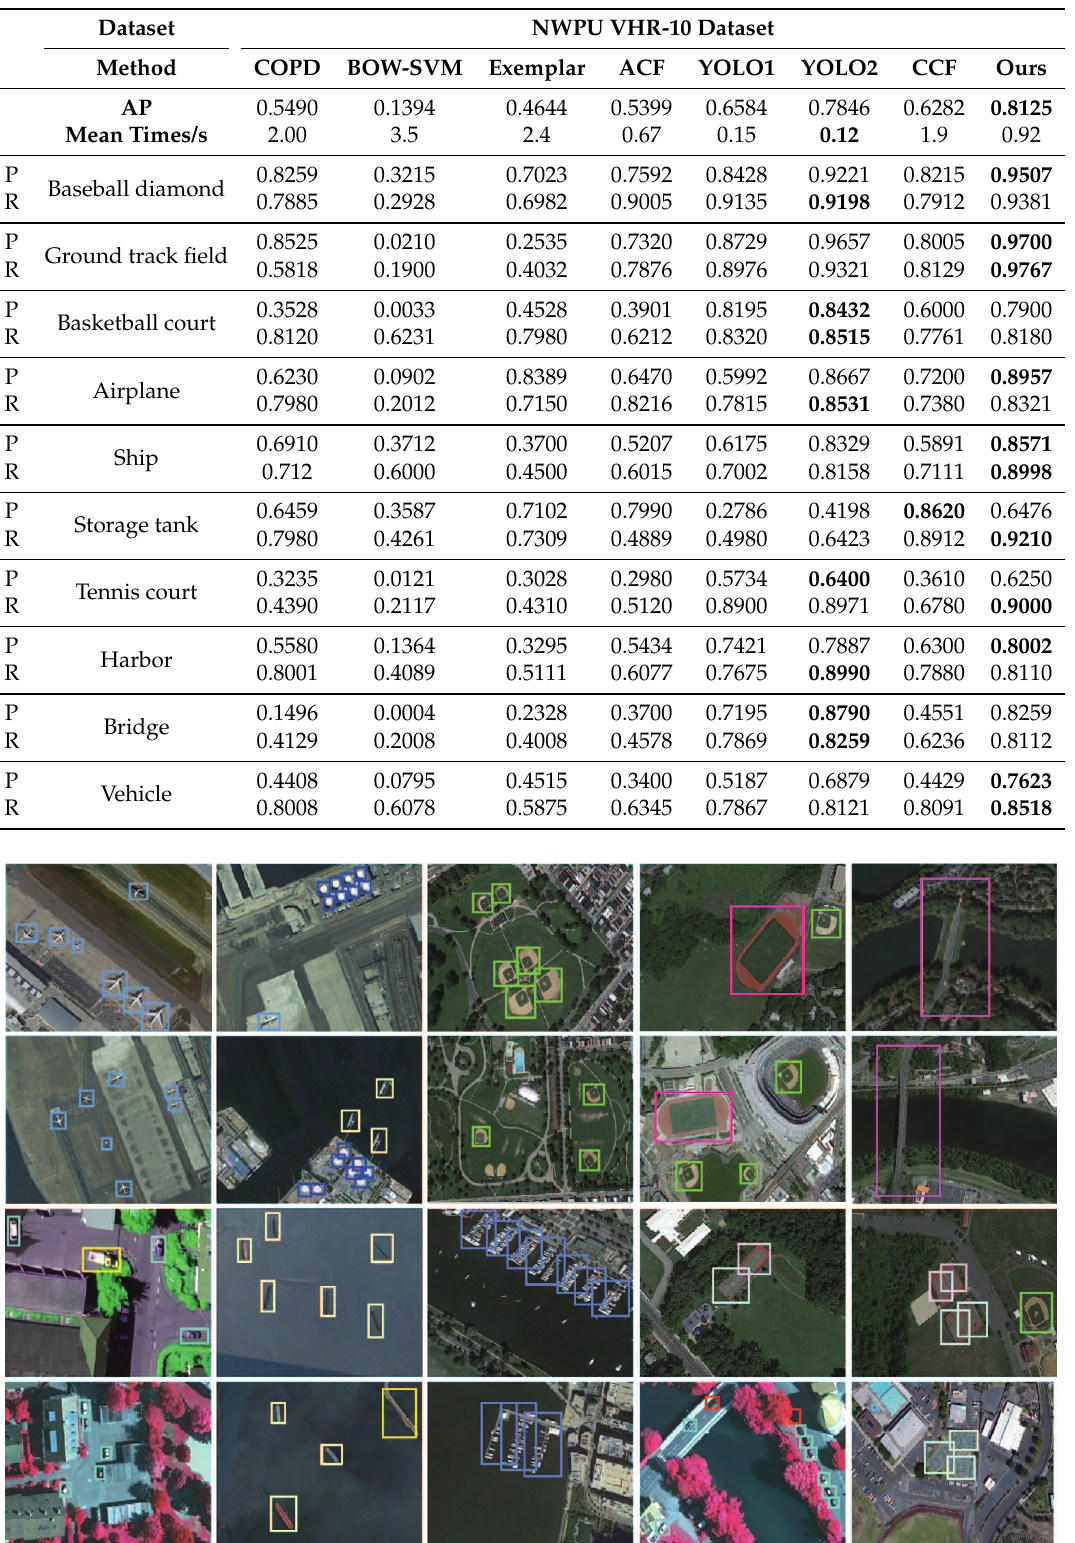
Table 6. Quantitative performance comparisons and average running time for the NWPU VHR-10 dataset. The optimal value is shown in bold.